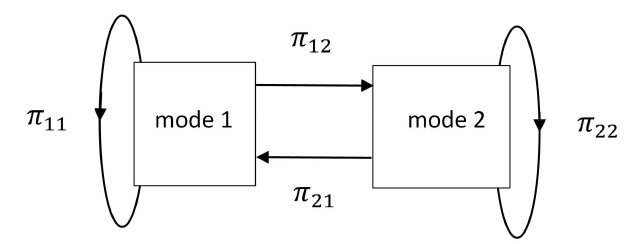
Figure 3. Graphical illustration of state-transition